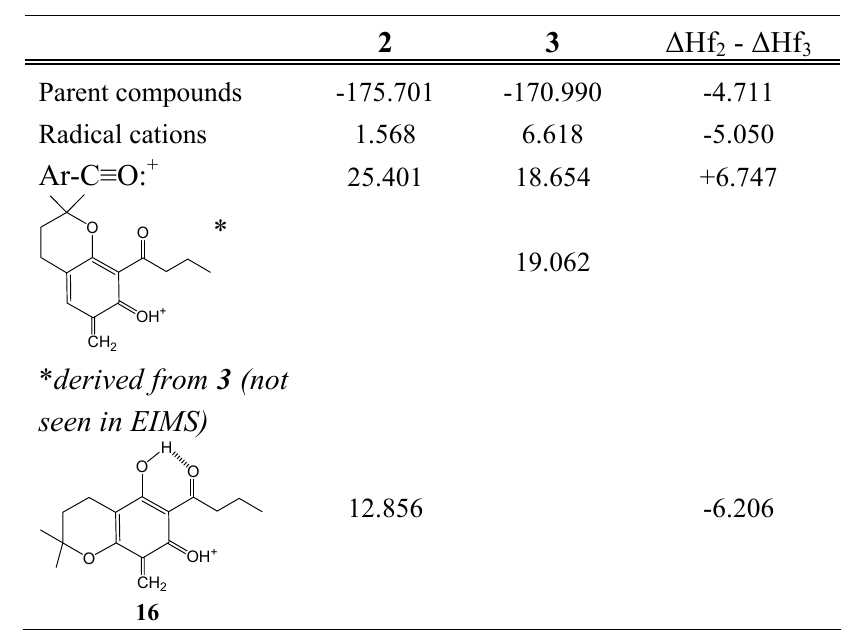
. + 2 Table 2 . AM1 relative energies (kcal.mol -1 ) calculated for 2 and 3 and select cationic species derived from these benzodipyrans. The relative energies for 16 and its analogous ion from the "linear" isomer (not seen in EIMS) are also shown for comparative